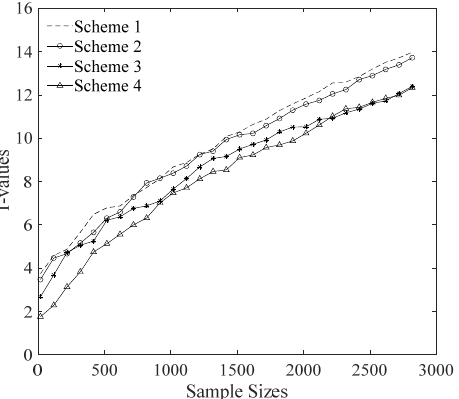
Figure 8. The maximum t -values of each scheme under different total sample sizes on FPGA.